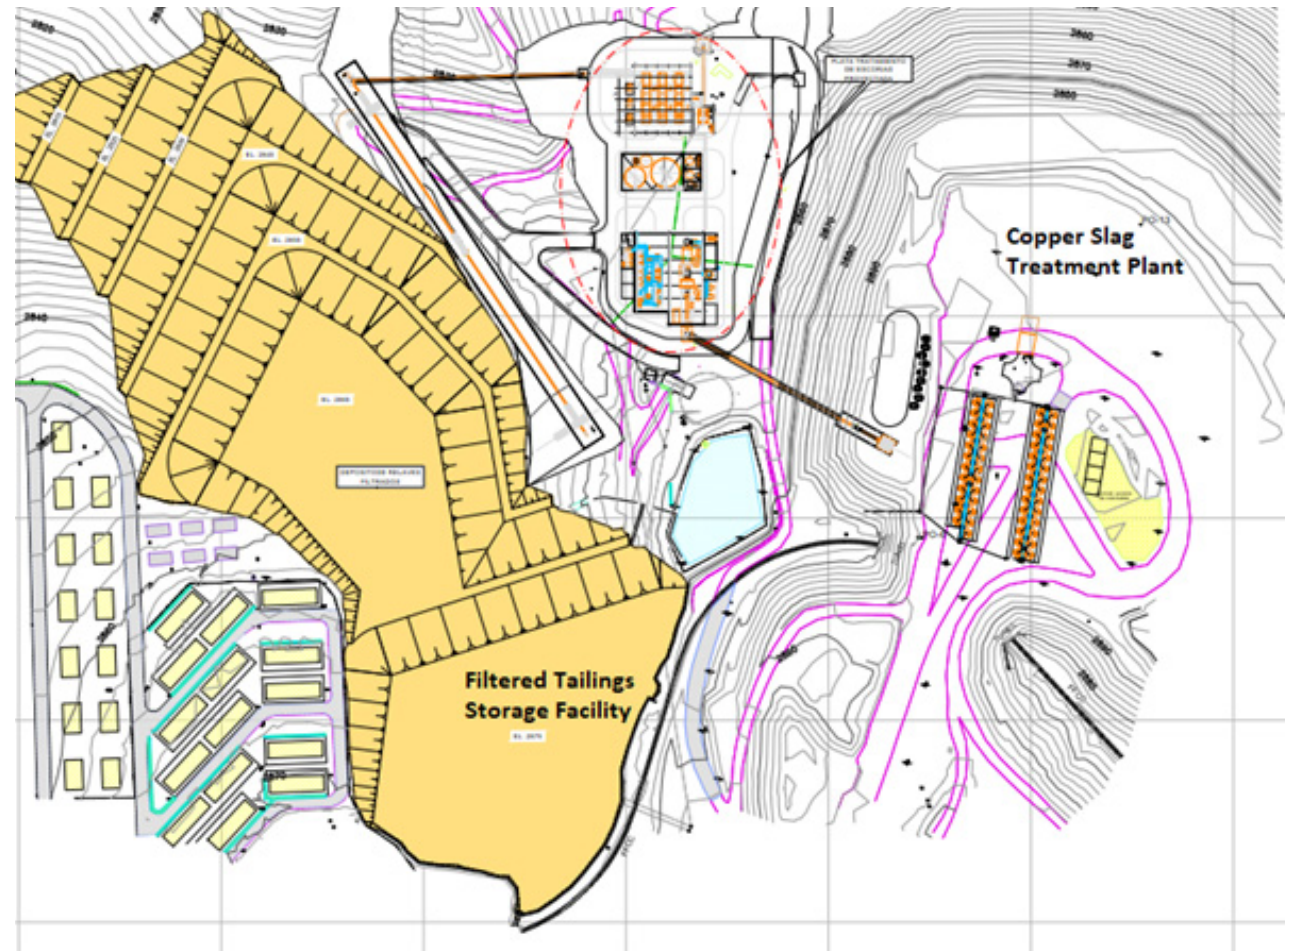
Figure 51. Potrerillos Filtered Tailings Storage Facility Layout [18,69].